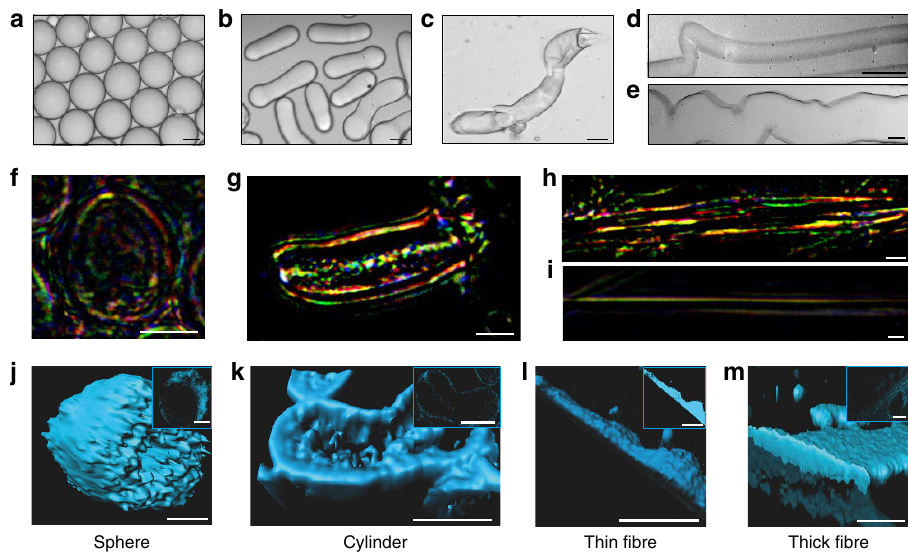
Figure 2 | Micrococoon morphology. Bright field microscopy images of NSF micrococoons: ( a ) spheres, ( b ) cylinders, ( c ) short fibres, ( d ) thin fibres and ( e ) thick fibres. Scale bar, 5 m m. Images of micrococoon structures placed between crossed polarizers: ( f ) sphere, ( g ) cylinder, ( h ) thick fibre, ( i ) thin fibre. Scale bar, 10 m m. 3D reconstructions of confocal images are shown for: ( j ) a sphere, ( k ) a cylinder, ( l ) a thin fibre, ( m ) a thick fibre. The z-stack central cut images are shown in the inserts. Scale bar, 10 m